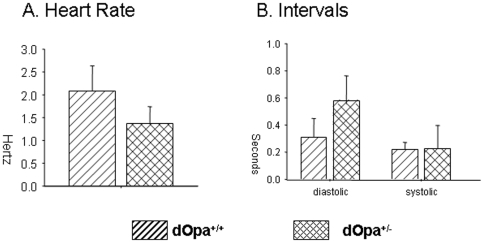
A. Heterozygous mutation of dOpa1
results in decreased heart rate (p<0.001). Single dashed bars represent dOpa1+/+ and double dashed bars represent dOpa1+/− Drosophila. Error bars are standard deviation of the mean. Heart rates were recorded at 3 weeks of age. Figure 5B. The decreased heart rate shown in Figure 5A was predominantly due to an increase in diastolic intervals (<0.001), not an increase in systolic intervals (0.09).